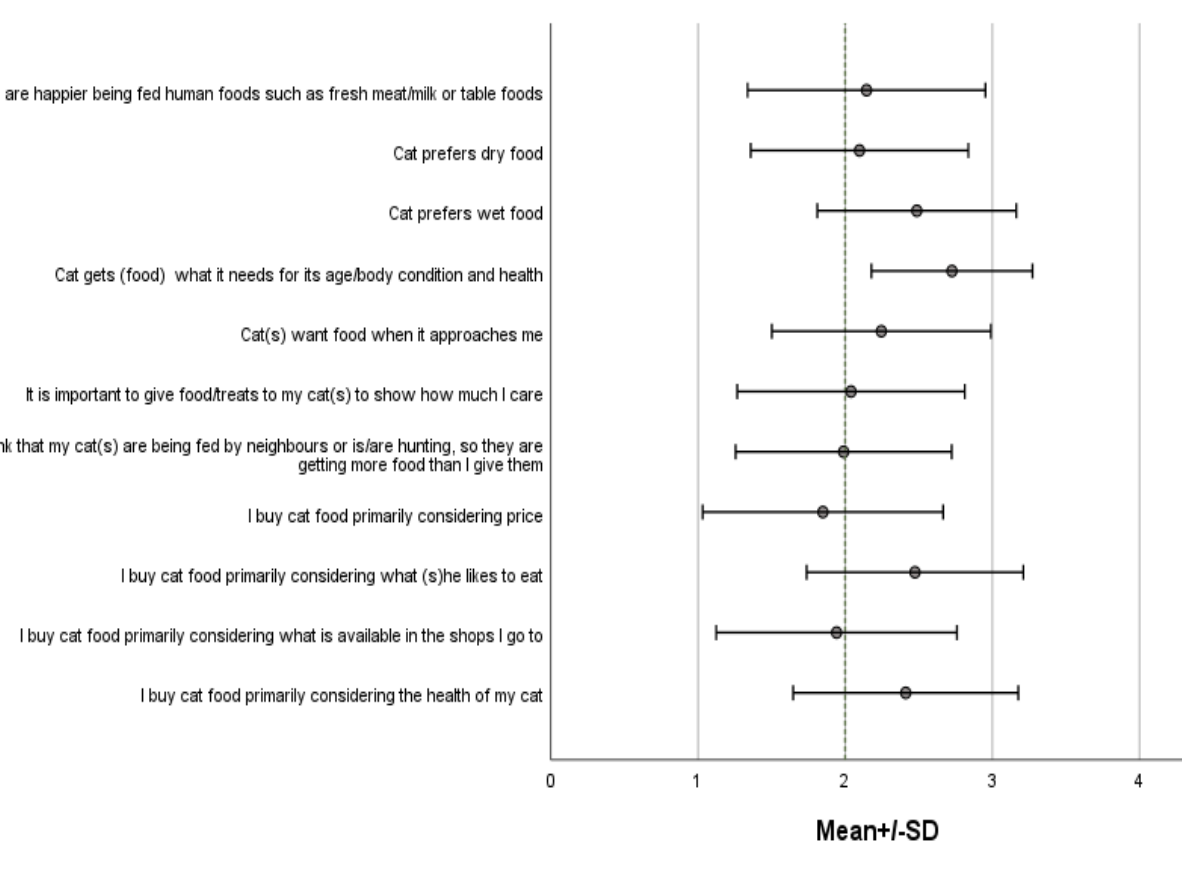
Table 6. Owners attitude of cats dietary preferences, needs and the drivers of shopping for cat food. A full set of cross-tabulated results is shown in Supplementary Materials (Table S2).